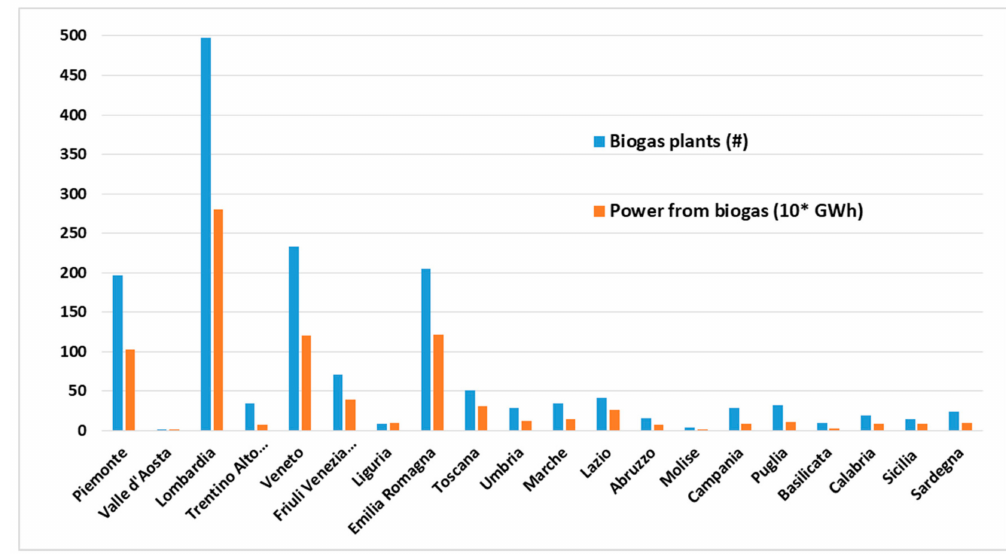
Figure 1. The number and the power capabilities of biogas plants in the 20 Italian administrative regions (data source ISAAC Project [25],